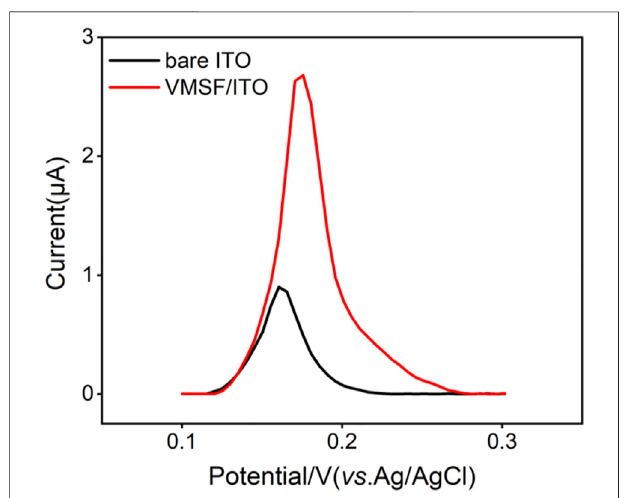
FIGURE 3 | DPV curves obtained from the bare ITO and VMSF/ITO electrodes in response to 1 μ M Hg 2+ in 0.1 M PBS (pH